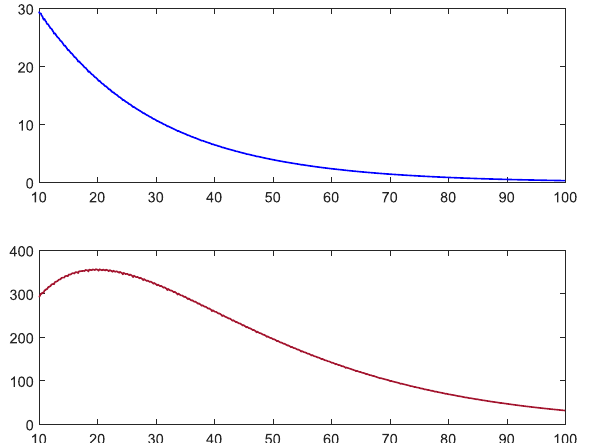
Fig. 1 The graphical plots of the numerical approximations of the energy E ( t ) (top) and the weighted energy tE ( t ) (bottom) the against t